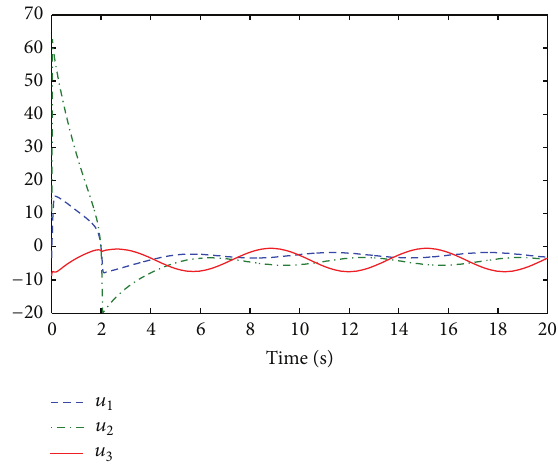
Figure 2: Tracking errors response. Figure 3: The control